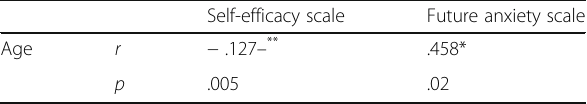
Table 7 Correlation between age and both future anxiety scale and